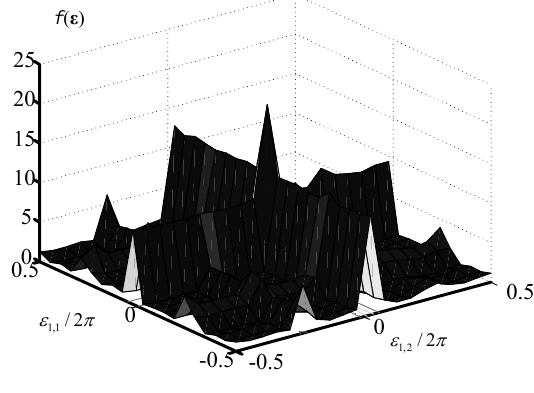
Fig. 4. Objective function value of Multi-objective